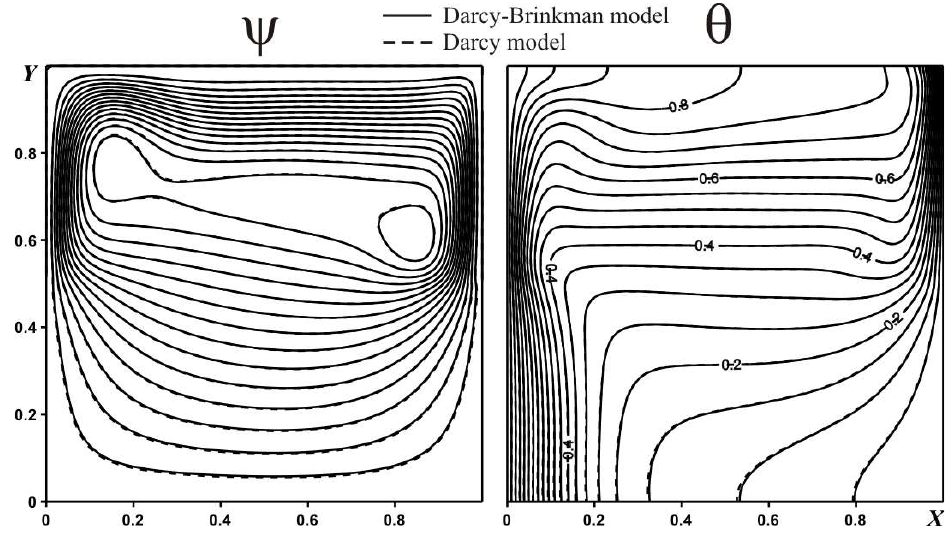
Figure 4. Streamlines ψ and isotherms θ at Da = 10 − 5 and Ra = 10 6 : these obtained results have a good agreement with data from [20] (see Figure 2c in